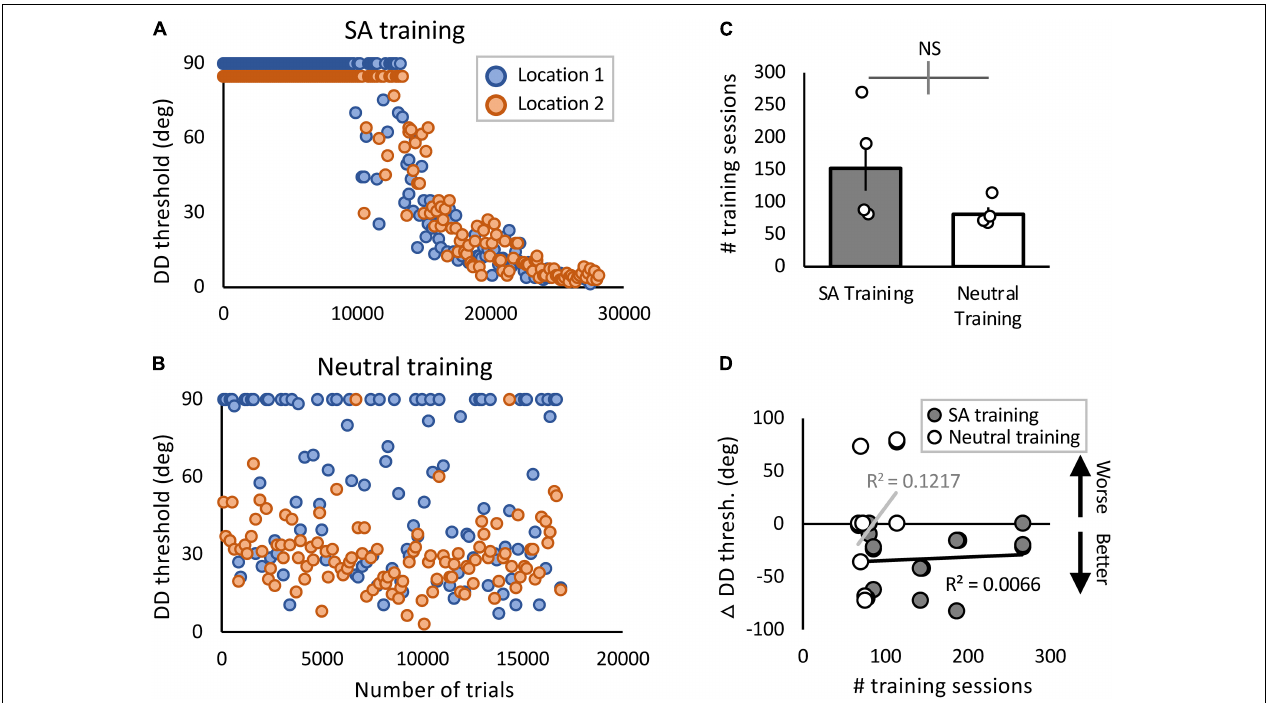
FIGURE 5 | Blind-field performance across training trials and sessions. (A,B) Example plots of 2 participants’ thresholds as a function of # trials during home training (A—CB4; B—CB7). Orange and blue data points represent daily performance at the two trained locations in each person, with 150 trials/session/location. In (B) , Locations 1 and 2 had the better and worse initial performance, respectively. In (A) , Location 2 sessions with a threshold of 90 are presented as 85 for illustrative purposes. (C) Plot of the total number of sessions trained in each cohort (means ± SEM) with individual data superimposed. There were no significant differences between groups. Gray error bar on the comparison line indicates ± 1 standard error of the difference between the compared means. (D) Plot of pre- to post-training change in DD threshold against the total number of training sessions performed by participants in the two training cohorts. There was no significant correlation between amount of training performed and DD thresholds in either training group (SA: t 8 = 0.23, p = 0.82; Neutral: t 6 = 0.91, p =